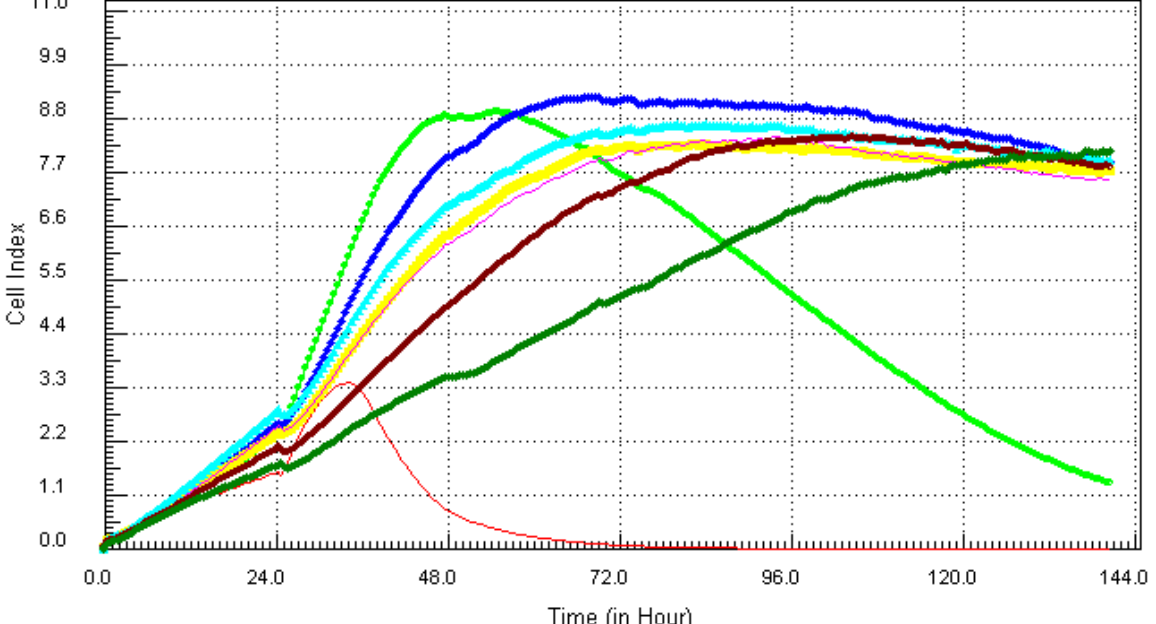
Figure 1. Kinetics of cytotoxic responses for Cadmium (Cd) in MCF7 cells monitored by the RT-CES system.10,000 cells/well were plated in 16-well strips for the RT-CES cytotoxicity assay. Different compound concentrations in µg/mL are indicated by different colors. Red = 21.7, light green = 10.8, blue = 5.4, yellow = 2.7, turquoise = 1.3, pink = 0.68, burgundy = 0.34, green =